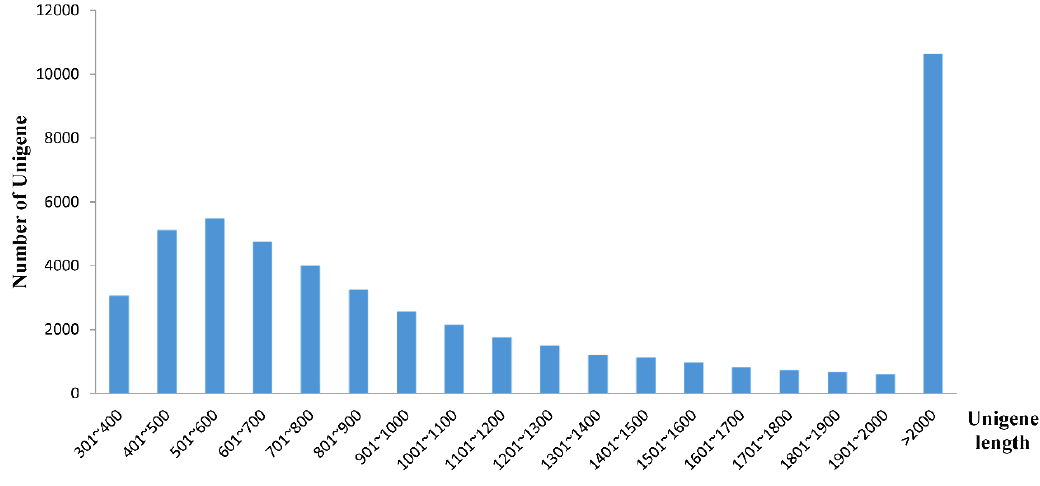
Figure 2. Histogram of the unigene length distribution. The x -axis indicates the length range of unigenes. The y -axis denotes the number of unigenes in every range of length.